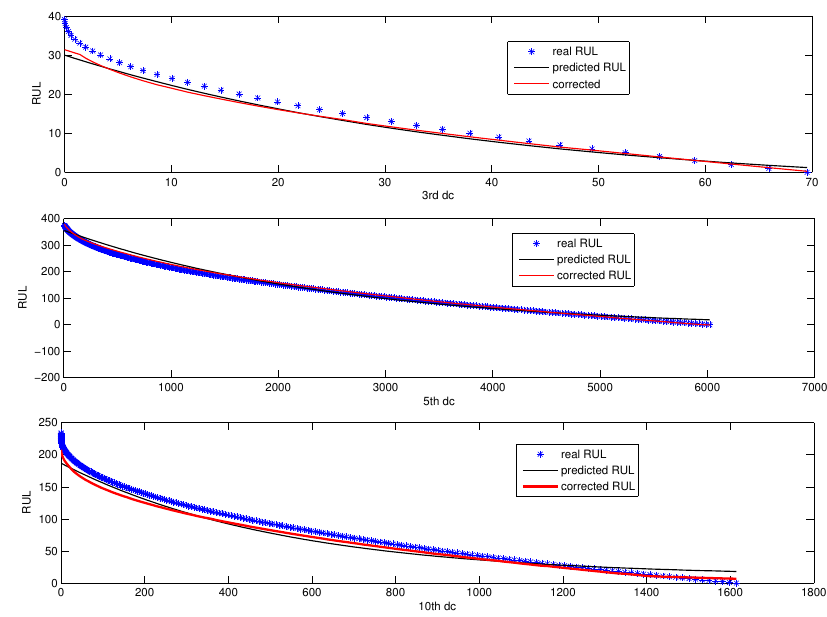
Figure 16. Online RUL prediction based on DC corresponding to D 3 , D 5 and D 10 .